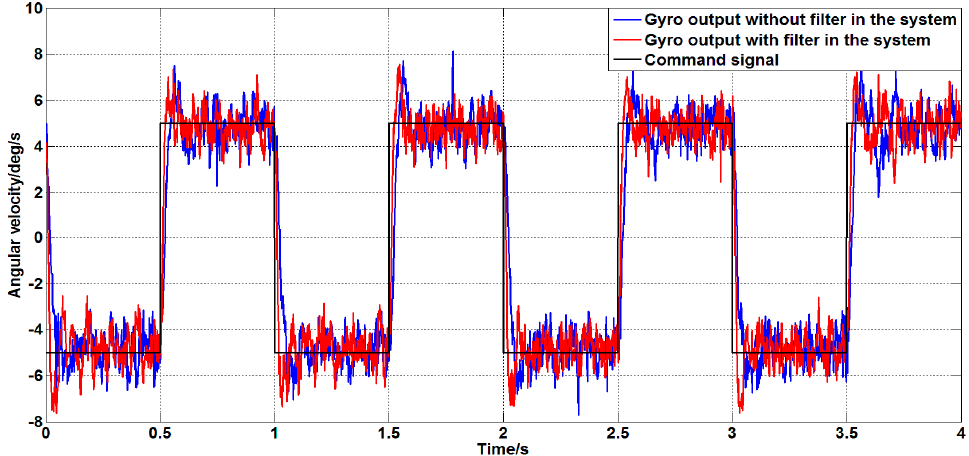
Figure 27. The step response of a system with or without a filter.